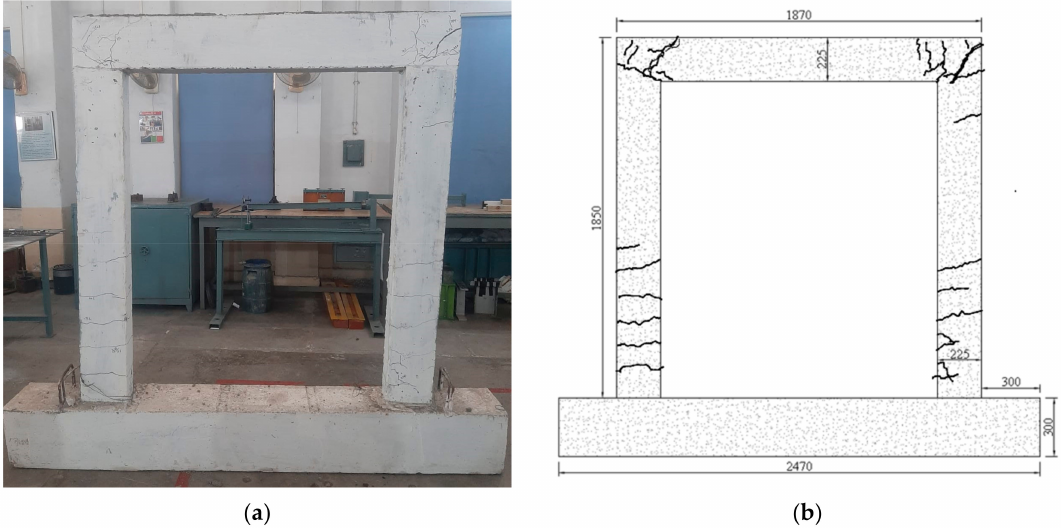
Figure 13. Crack pattern of GPC-BF ( a ) failure pattern of actual sample, ( b ) crack pattern diagram. The specimen OPC-CM. denoting a confined masonry wall panel made of ordinary Portland cement concrete, was dominated by the shear failure of confining elements and crisscross mortar joints (Figure 14). At a drift level of 0.22%, corresponding to a lateral load of 75.74 kN for the pushing direction, the first crack initiated at the bed joint of mortar near the top. On further increasing lateral load, the cracks started propagating downward through the bricks-mortar joints at 0.54% drift against 89.85 kN. Diagonal stair-stepped cracks spread from the column-beam joint to the bottom of the other column through the bricks interface at 1.08% drift and a lateral load of 103.21 kN. On increasing further lateral drift, flexural cracks appeared in one tie-column. The possible reason for flexural cracks is the rocking of the masonry panel after the reinforced tie-column approaches the maximum tension capacity at the base. Most of the diagonal cracks developed passed through the mortar joints and only a few went through the bricks. The wall specimen achieved maximum lateral load-bearing capacity in pushing and pulling direction as 114.29 kN and 108.48 kN against drift levels of 1.73% and 1.35%, respectively. The peak lateral displacement recorded in the test specimen was approximately 37.4 mm in the last pushing direction. The diagonal crack width was measured as 24 mm, whereas the largest width of flexural cracks in tie-column was noted as 9.0 mm. The damage in the specimen was mostly concentrated in the top one-third